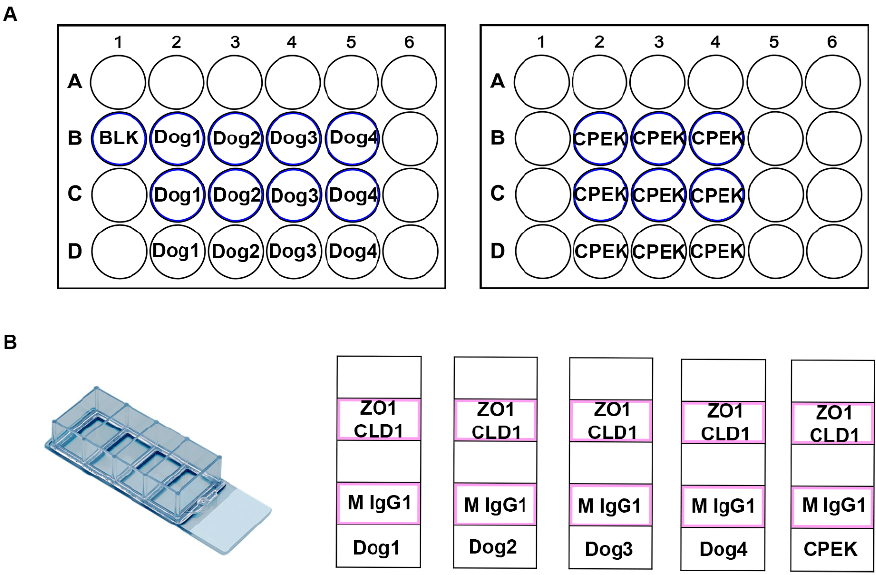
Figure 1. These are diagrams of our cell culture set up. ( A ) Represents the TransEpithelial Electrical Resistance (TEER) well set up. We had two 24 well plates with transwell inserts. The wells which had transwell inserts are represented with a blue outline. ( B ) Represents the chamber slide set up. These were Lab-TeK II Chamber Slides with 4 wells. Cells were grown in the chambers outlined in pink. ZO-1 (Thermo Fisher 339100) and Claudin-1 (Abcam ab15098) were used as primary antibodies with a secondary stain of donkey anti mouse IgG 488 (Thermo Fisher A10042) and donkey anti rabbit 594 (Thermo Fisher A21202). Mouse IgG1 Isotype Control (Thermo Fisher MA5-14453) was used as a negative control.